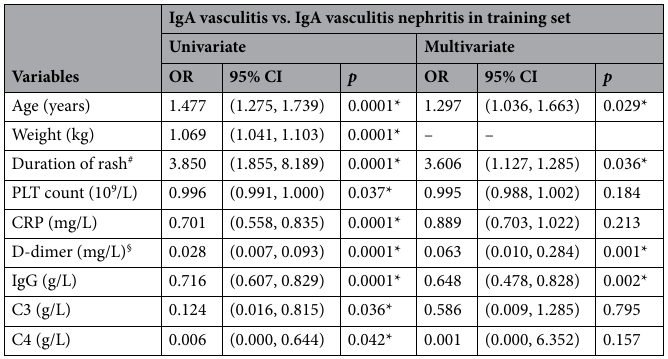
Table 2. Univariate and multivariate analysis of risk factors for nephritis in IgA vasculitis in training set. * p < 0.05 for significance. # Means the time of rash recurrent or persistent. § The result is the square root of the D-dimer. PLT platelet, CRP C-reaction protein, CI confidence interval, OR odds ratio.